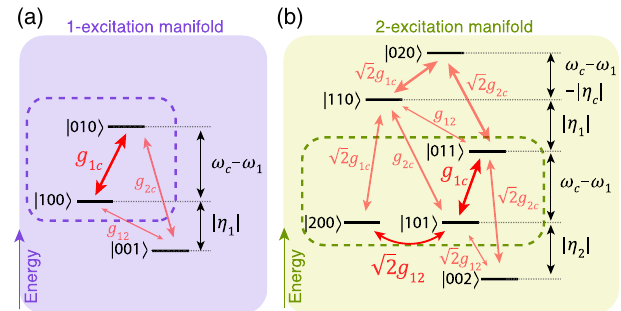
FIG. 16. Energy level diagrams of the single-excitation mani- fold (a) and the double-excitation manifold (b) when performing the CZ gate. The dashed boxes indicate subspaces spanned by energy levels that are relevant to coherent leakage during the CZ gate. The red double-headed arrows denote exchange interactions between the energy